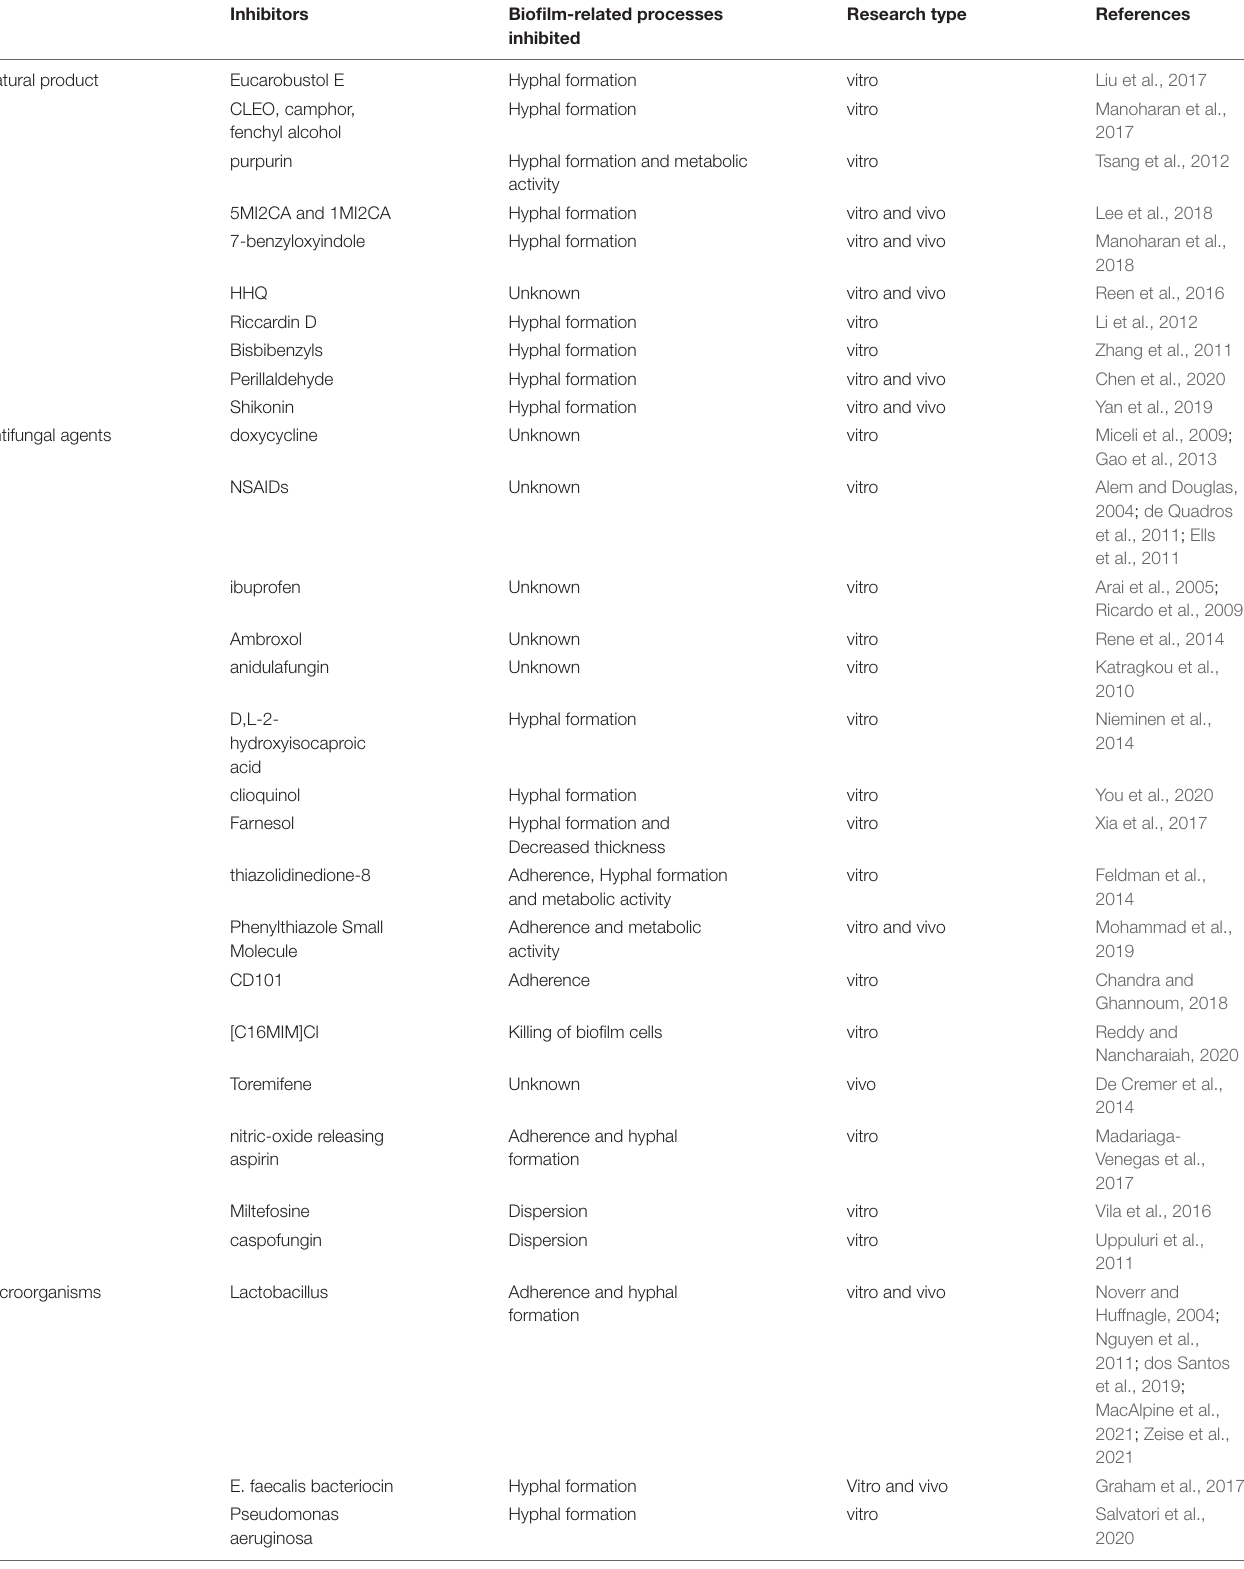
TABLE 1 | Inhibitors involved in C. albicans biofilm